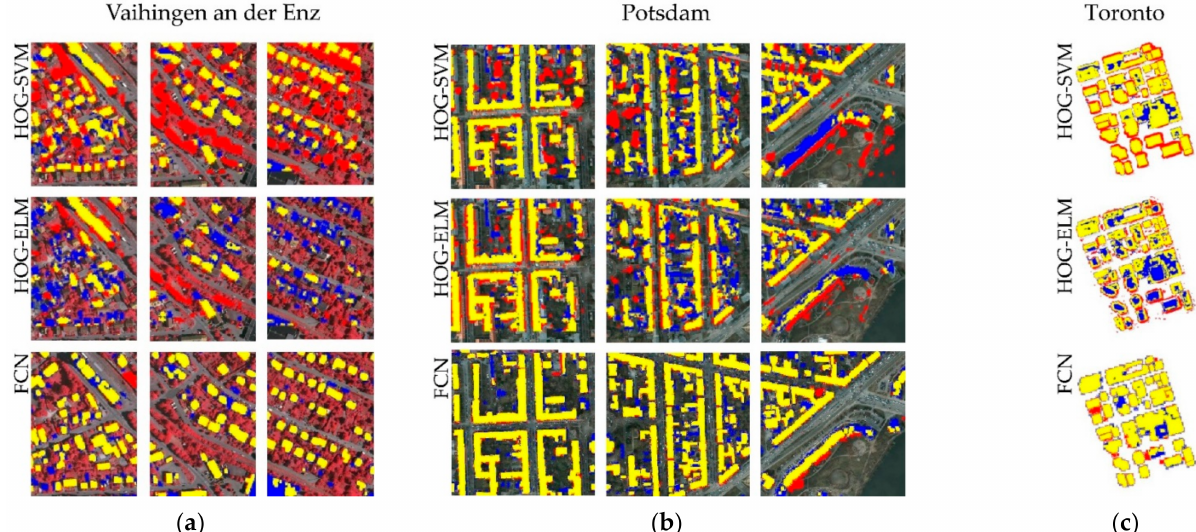
Figure 6. Contingency maps obtained from a pixel-to-pixel comparison between the masks outputted by the models and the ground truth by urban area: ( a ) Vaihingen test set, ( b ) Potsdam test set, and ( c ) Toronto test set. True positives are shown in yellow, false positives in red, and false negatives (missed building pixels) in blue.